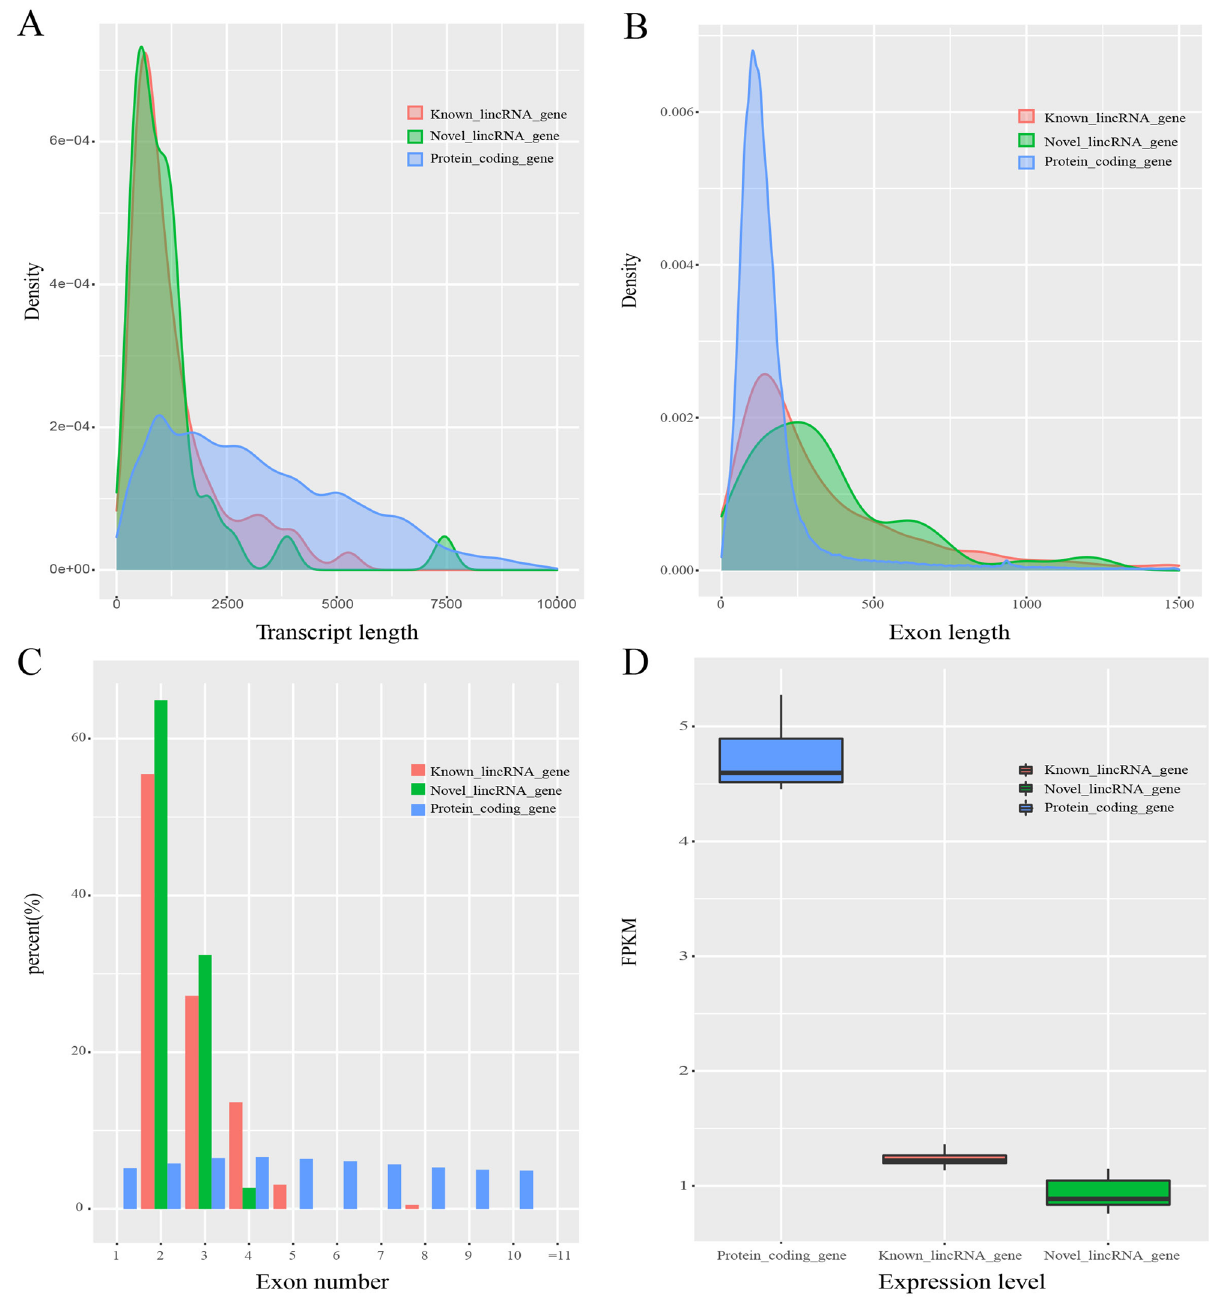
Figure 2. Characterization of lincRNAs compared with protein-coding genes; (A) Comparison of transcript length; (B) Comparison of exon length; (C) Comparison of numbers of exon; (D) Comparison of expression